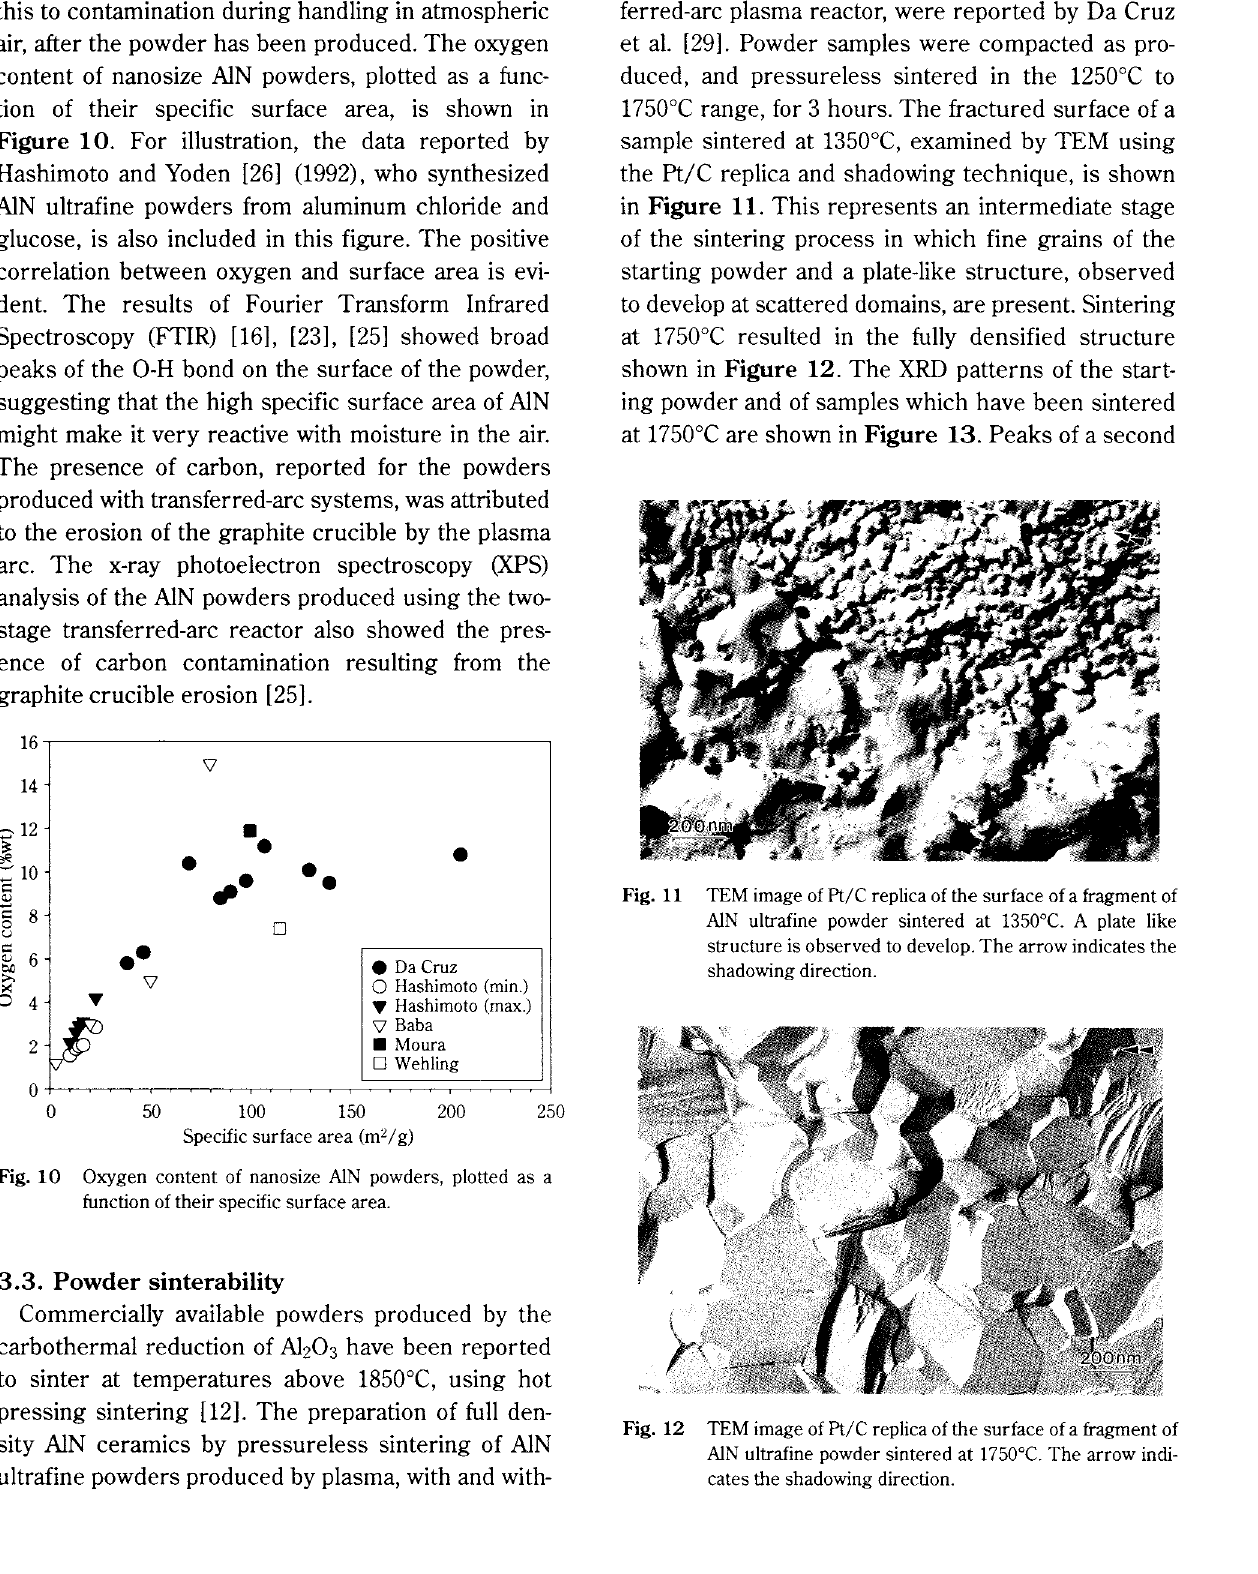
Fig. 11 TEM image of Pt/C replica of the surface of a fragment of AIN ultrafine powder sintered at 1350°C. A plate like structure is observed to develop. The arrow indicates the shadowing direction.